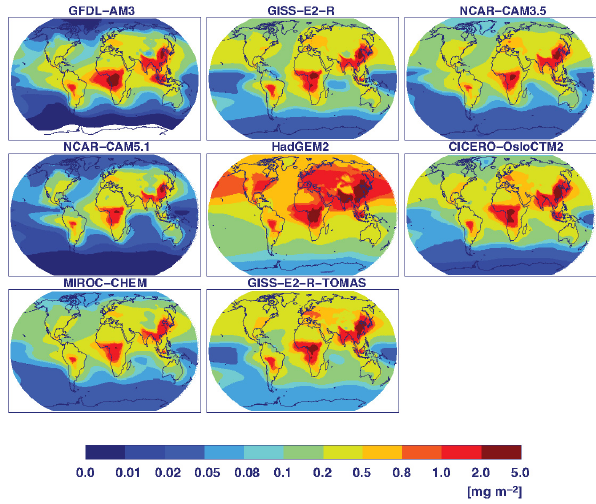
Fig. 2. Global distribution of BC column burden in